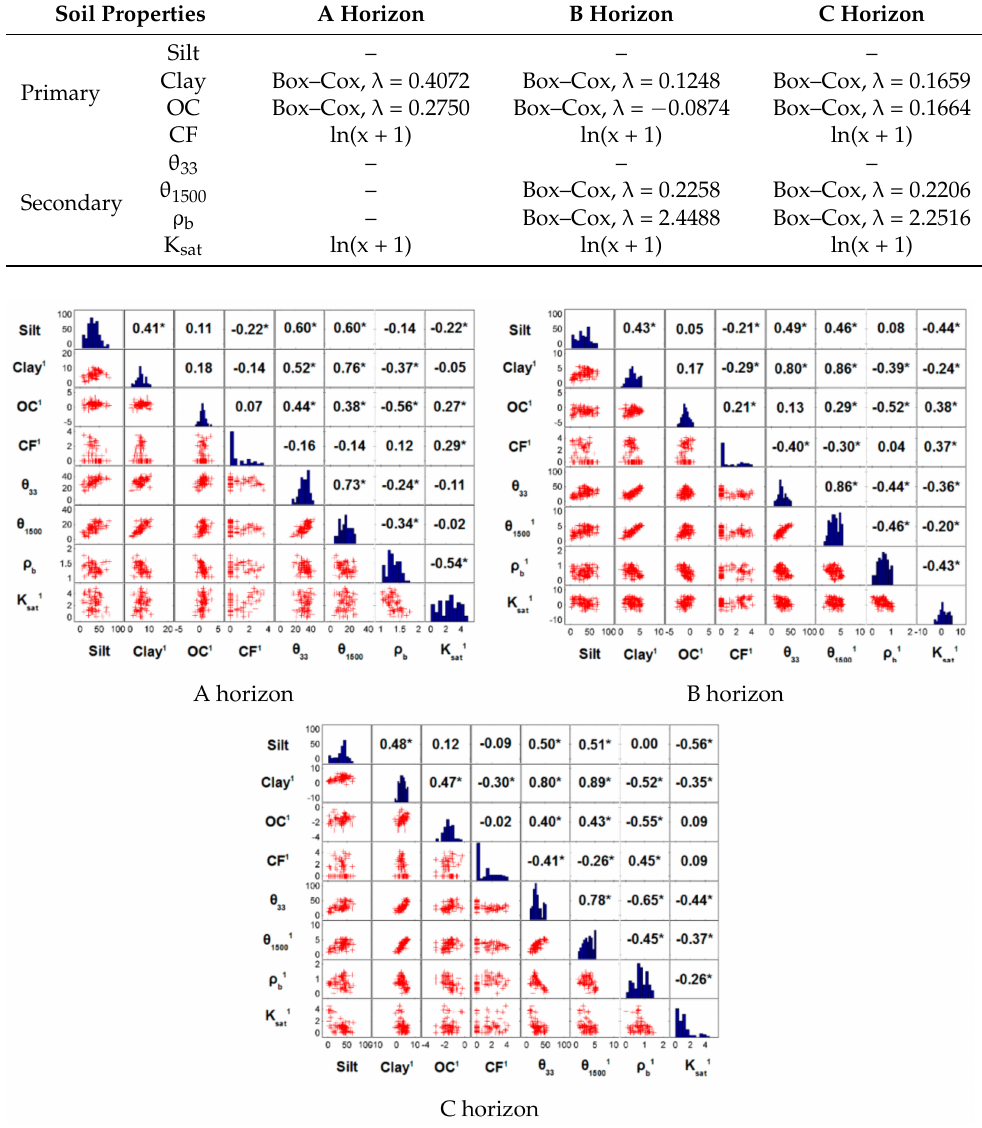
Figure 3. Cross-correlation and distribution matrix of primary and secondary soil properties. 1 Trans- formed data; * significant correlation ( p =